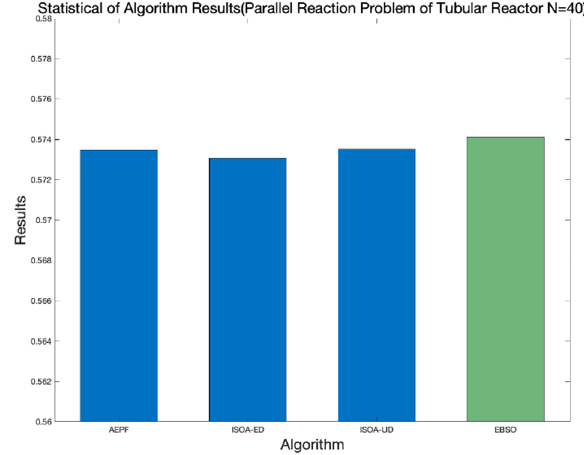
Figure 38. Statistical chart of algorithm results. Table 11. Comparison of methods of parallel reaction problem of isothermal tubular